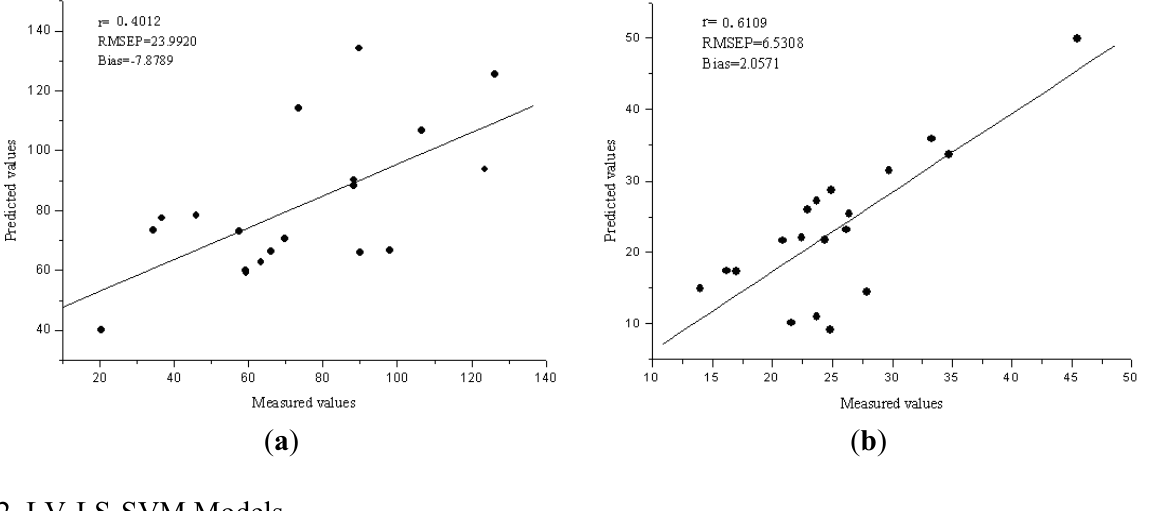
Figure 2. ( a ) The predicted versus reference values for Fe by PCA-LS-SVM model. ( b ) The predicted versus reference values for Zn by PCA-LS-SVM